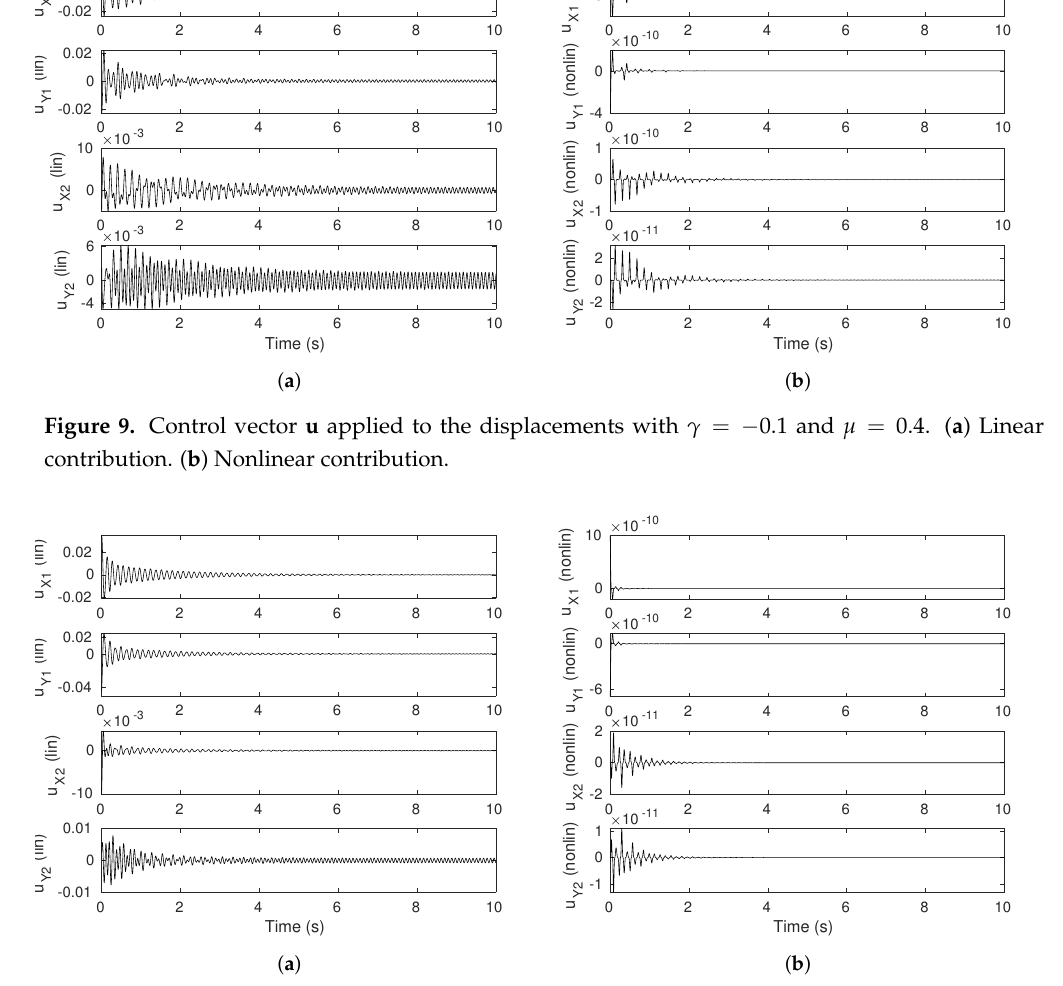
Figure 10. Control vector u applied to the displacements with γ = − 0.1 and µ = 0.7. ( a ) Linear contribution. ( b ) Nonlinear